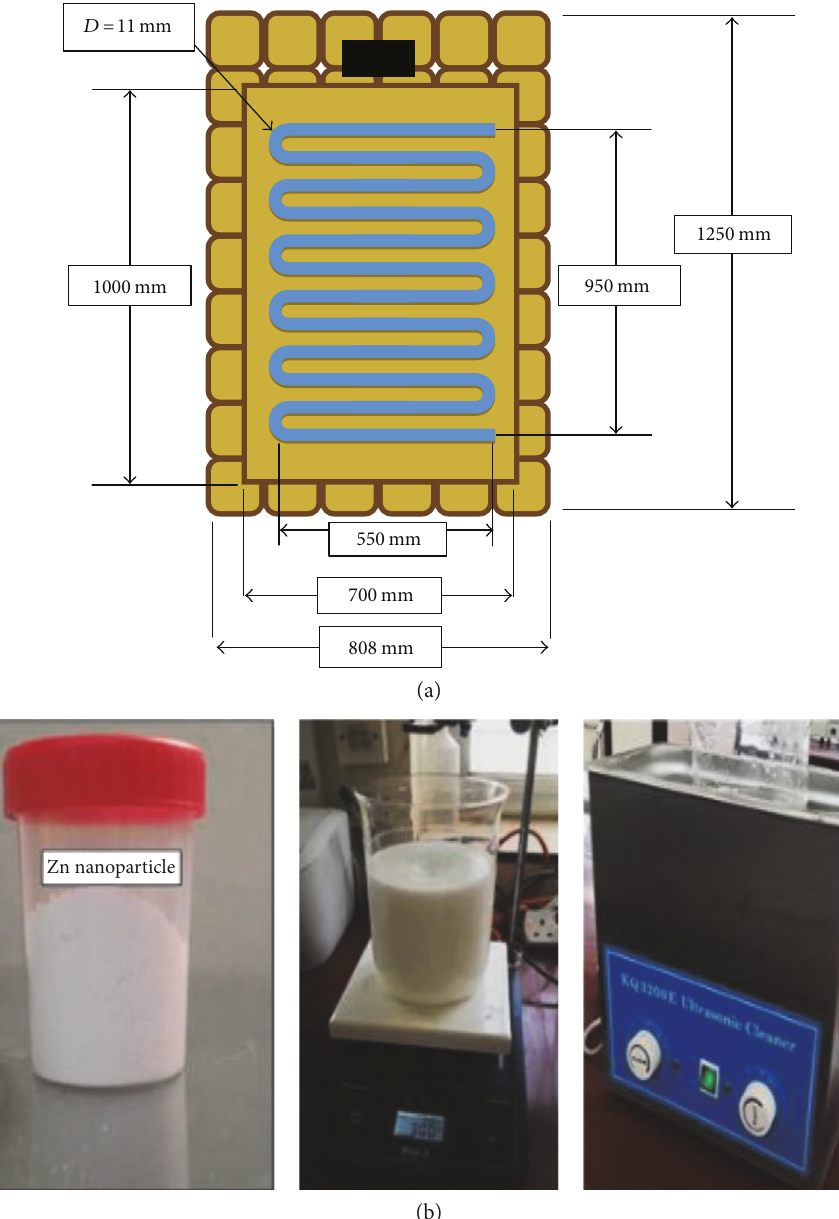
Figure 2: (a) Dimensions of thermal pipes mounted on the backside of PV. (b) Steps of nano fl uid